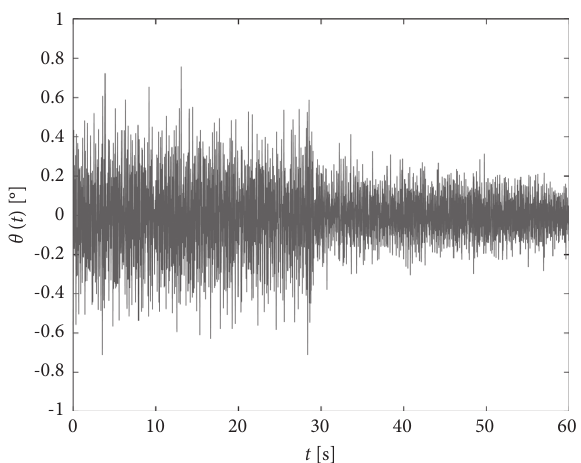
Figure 26: The illustration of the set